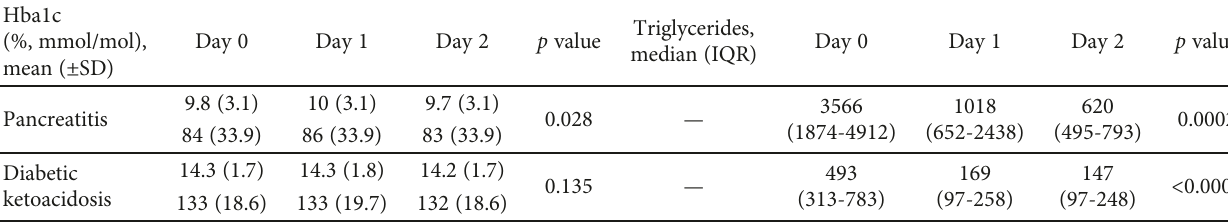
Table 3: Mean HbA1c and TG among groups (DKA and HTG-IP).